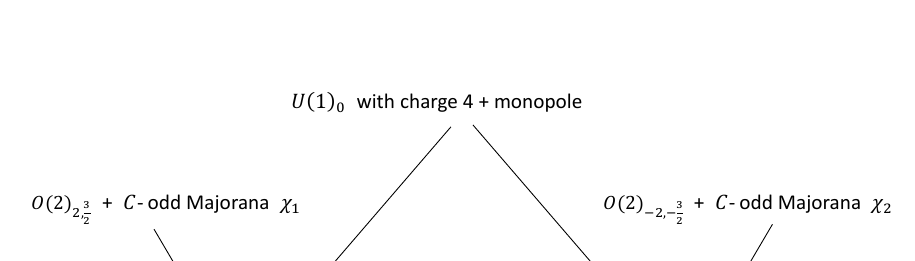
gauge field of O ( 2 ) by 2